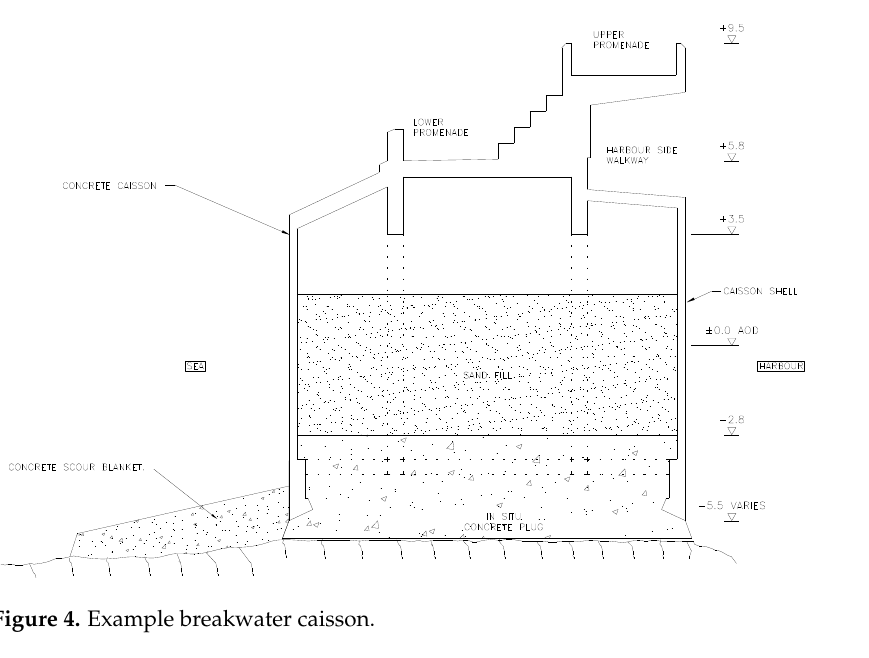
Figure 4. Example breakwater caisson.